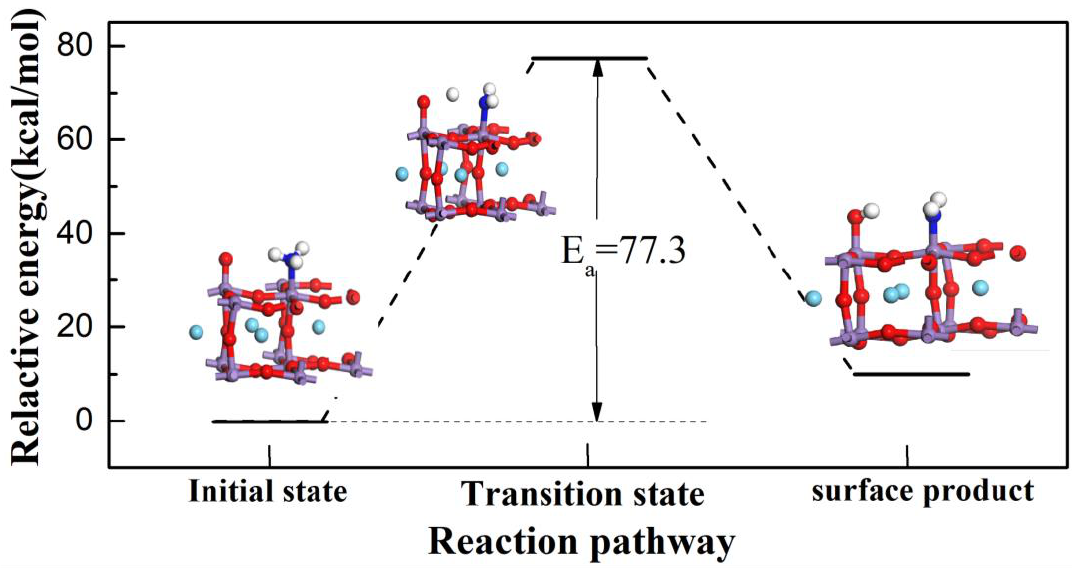
Figure 9. The dehydrogenation process of NH 3 under the action of active O oxygen. Whether NH 2 can continue to be oxidized and dehydrogenated under the action of active O was also addressed, and the process is indicated in Figure 10. The active energy barrier was found to be 100.5 kcal/mol and the reaction heat was 10.4 kcal/mol. It can be seen that the active energy was much higher than in the previous example of dehydrogenation, which means that NH is not easy to generate in this state.